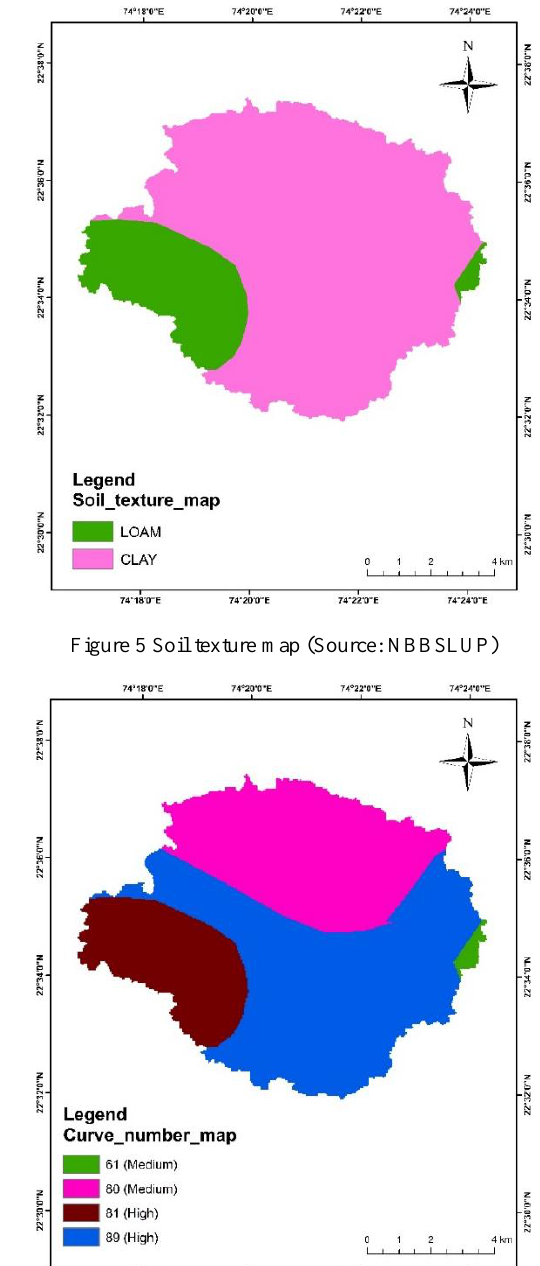
Figure 6 Curve number